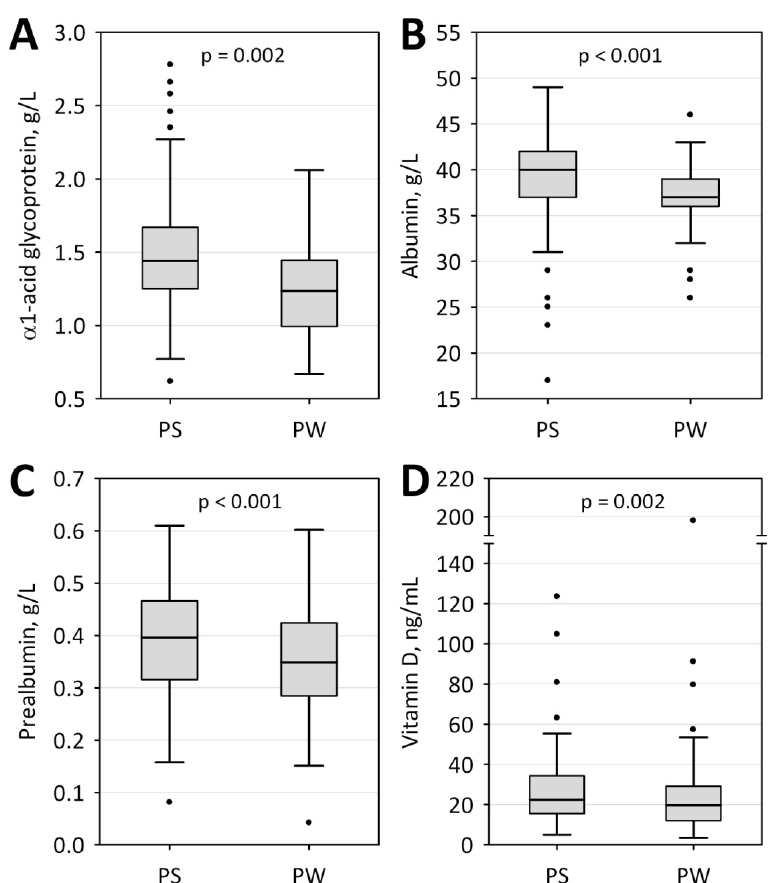
Figure 1. Changes in concentrations of selected parameters measured in post-summer (PS) and post–winter (PW) periods: α 1- acid glycoprotein ( A ), albumin ( B ), prealbumin ( C ), and vitamin D ( D ). Data are shown as the median (central line), lower–upper quartile (box), non-outlier range (whiskers), and outliers (points).